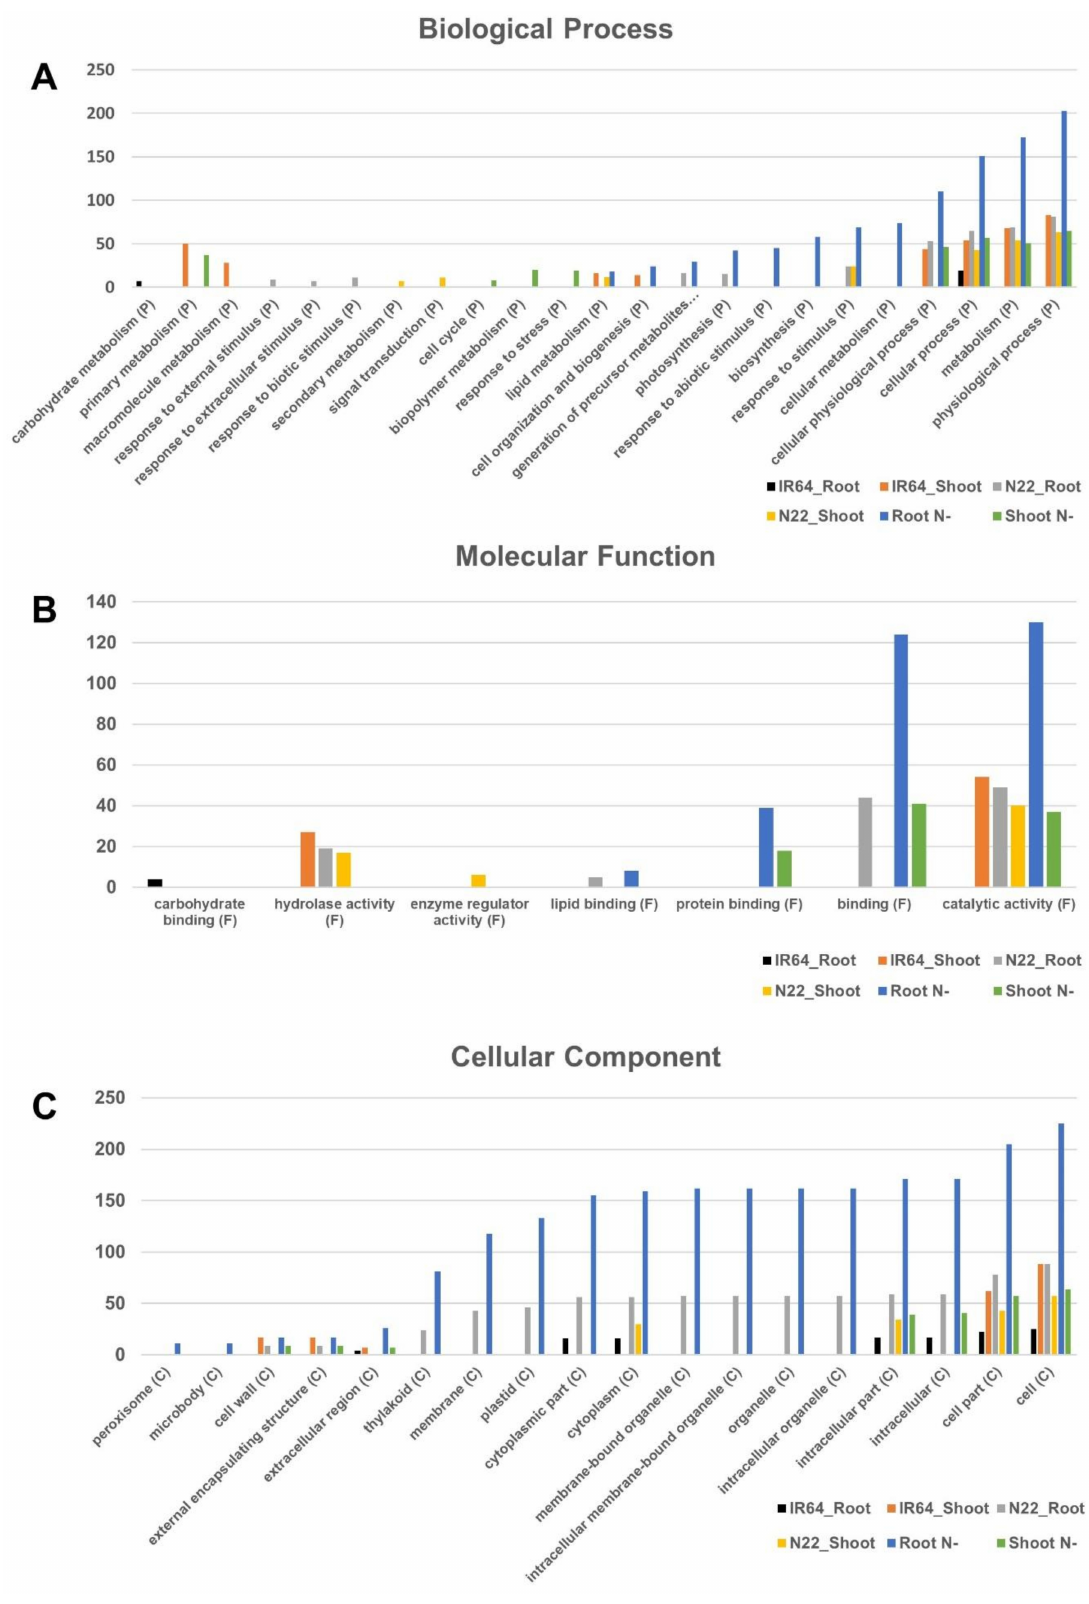
Figure 6. Functional classification of DEGs identified under optimal (N+) and low N (N − ) in IR64, Nagina 22 and IR64 vs. N22 based on Gene Ontology (GO) terms, showing GO category distribution. ( A ) Biological process; ( B ) Molecular function; ( C ) Cellular